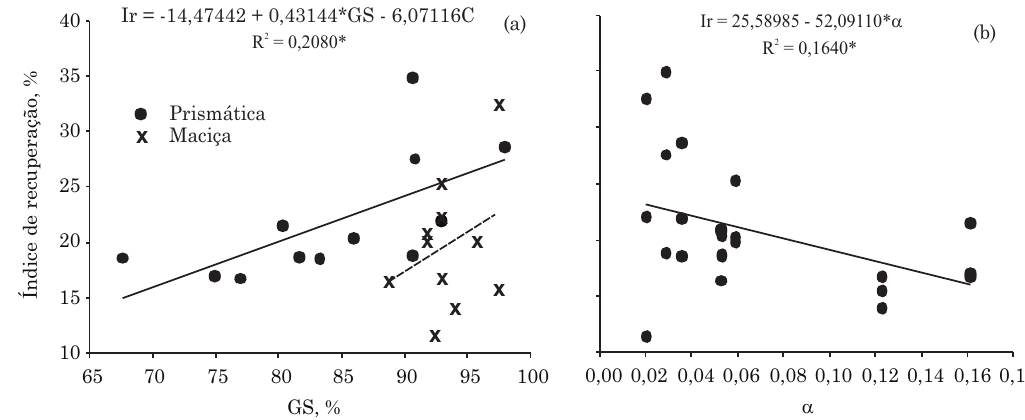
Figura 3. Regressão linear do índice de recuperação (Ir) em razão grau de saturação (GS) (a) e alpha ( ααααα ) para o Gleissolo Háplico (b). C refere-se à classe de estrutura (valor 1,0 quando prismática e 0,0 quando maciça). ** e * significativo a 5 e 1 %, respectivamente. N =